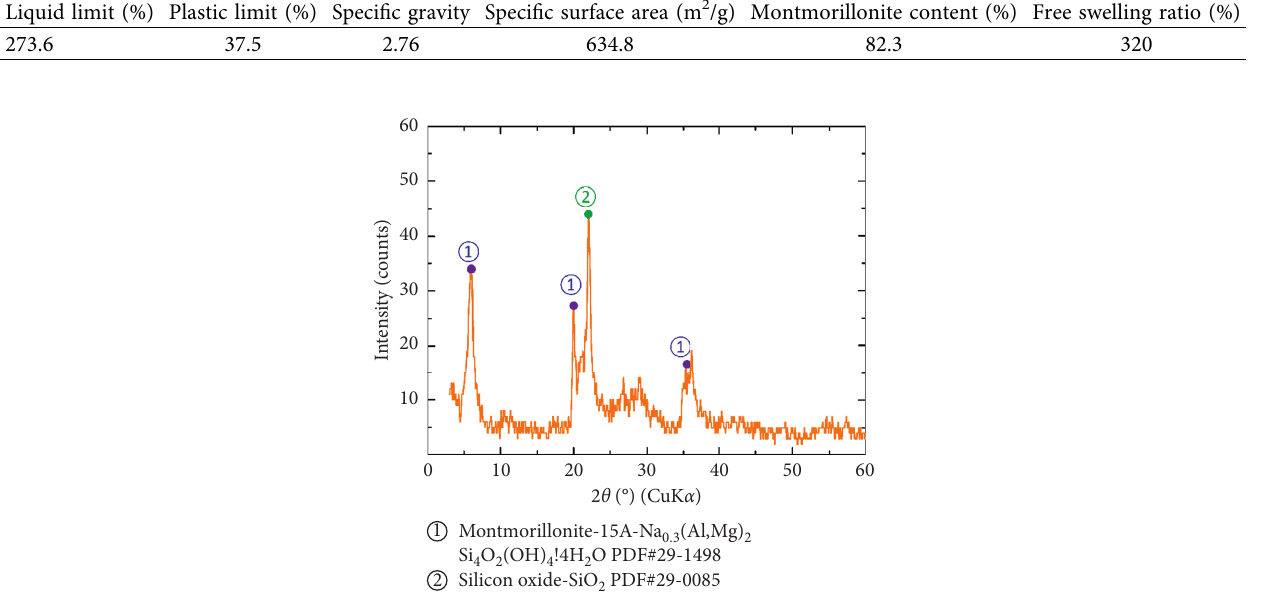
Table 1: Basic properties of bentonite.